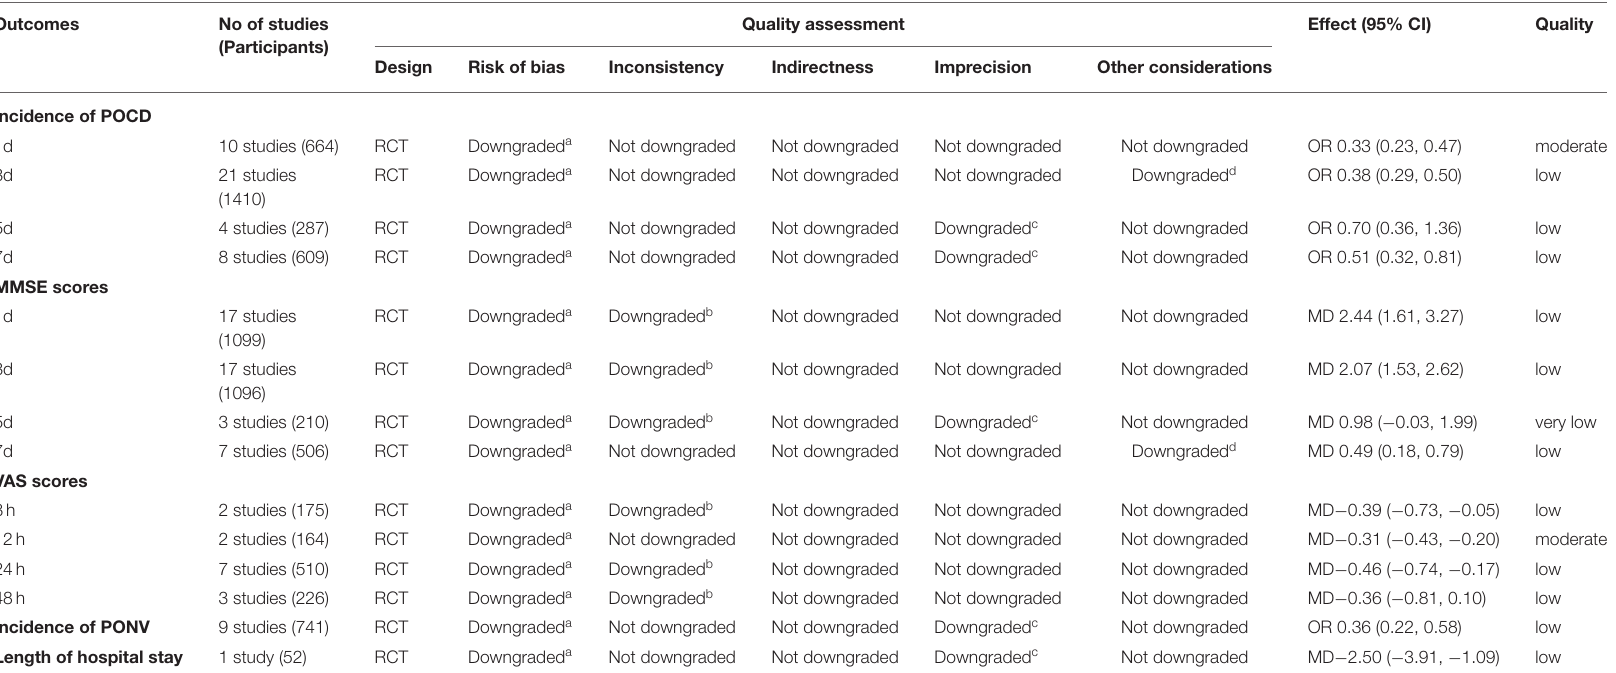
TABLE 2 | Main findings and evidence quality of the meta-analysis of TEAS for the prevention of